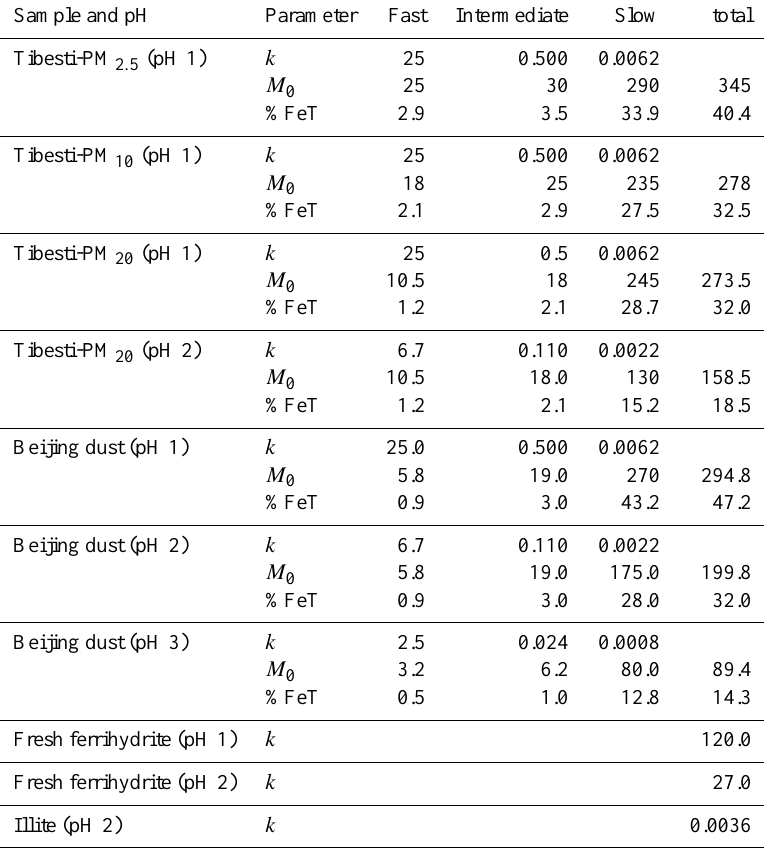
Table 2. Rate constant k (h − 1 ) and initial amount of each Fe pool M 0 (in µmolg − 1 ) used to model the Fe dissolution curves of Beijing and Tibesti dust samples (60mgL − 1 ) and reference